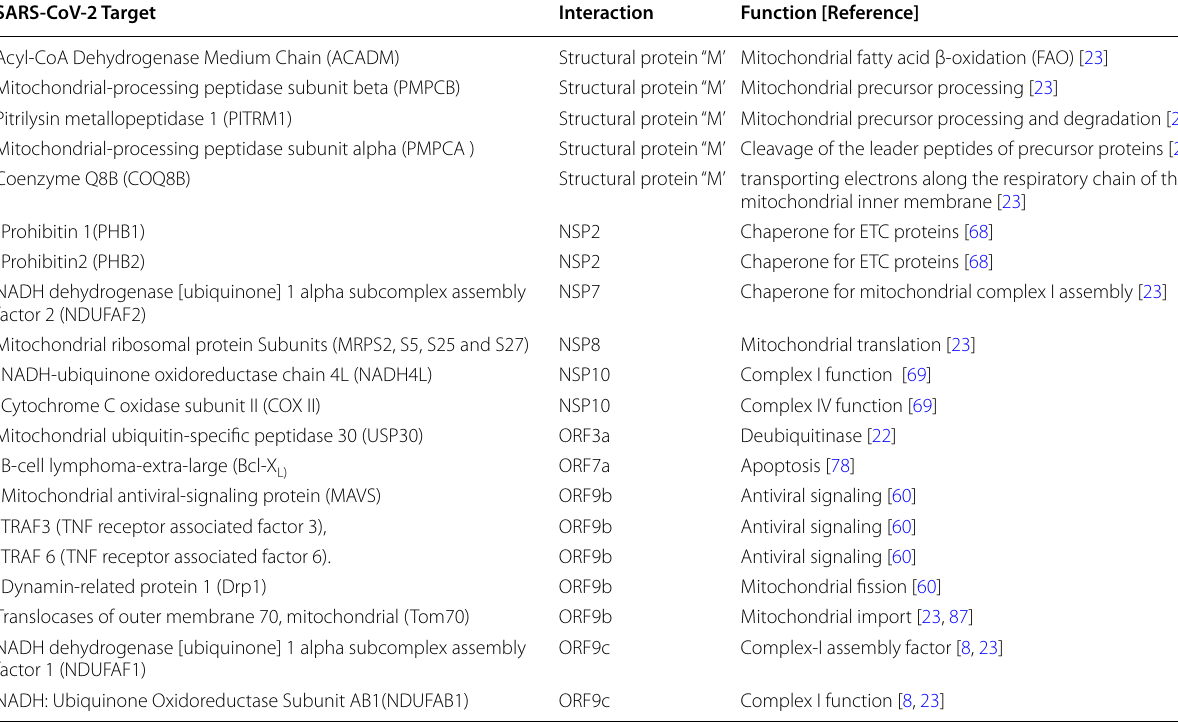
a Predicted interactions based on conserved structure and functions from SARS-CoV